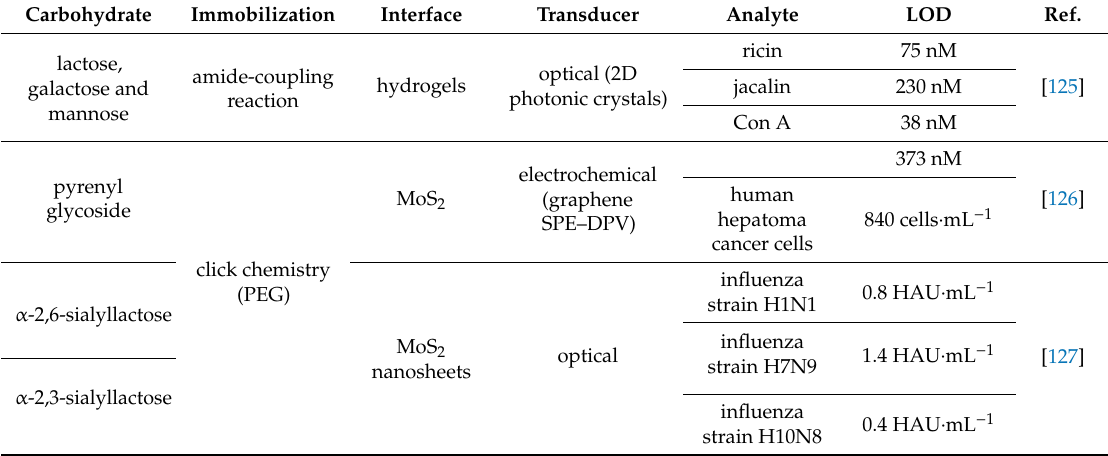
Figure 18. Rise of lateral stress inside the polymer receptor layer with sialyloligosaccharide groups after binding virus particle. Reproduced with permission from [132]. Copyright the Royal Society, 2019.